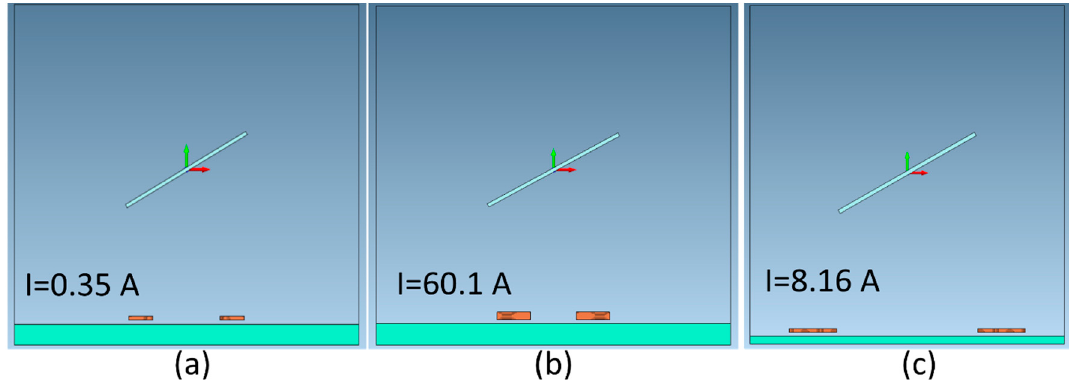
PL ( a ), F AT ( b ), F SV ( c